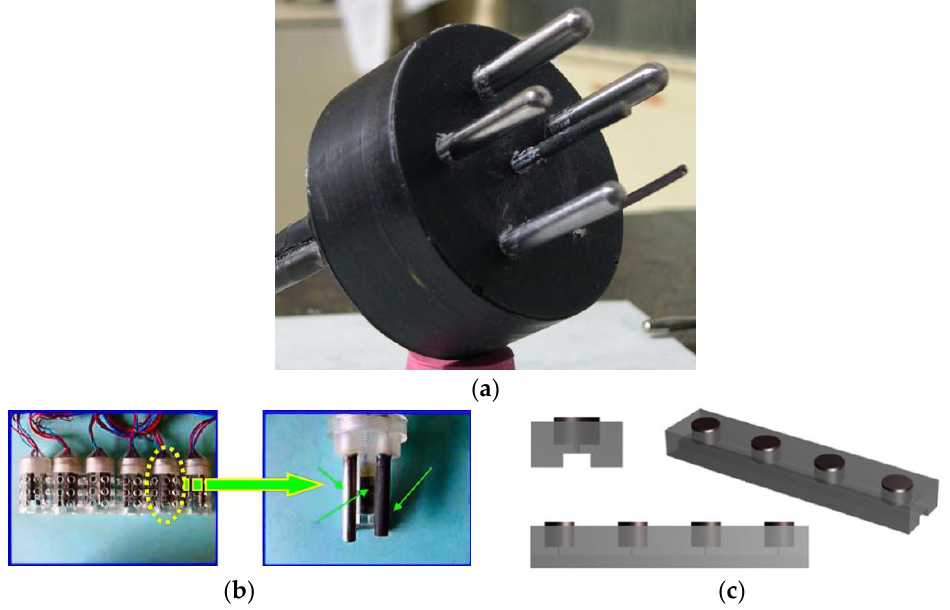
Figure 4. Examples of multifunctional sensors: ( a ) Duffó and Farina [160]; ( b ) Qiao et al. [164]; ( c ) Jeong and Kim [166].